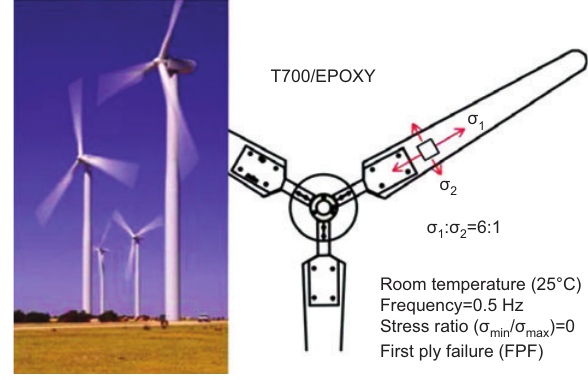
Figure 18 Wind turbine blade material, loading and fatigue conditions.